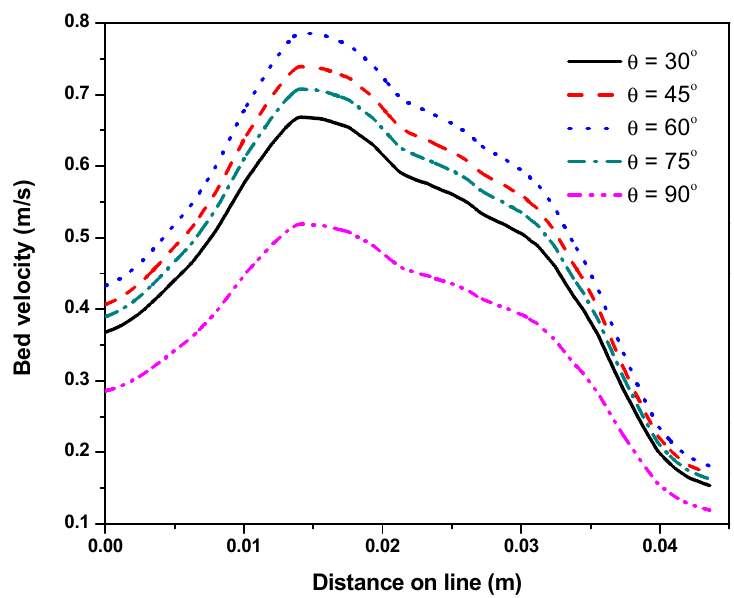
Figure 6. Bed velocity as a function of distance on line for a 500 g bed weight and different blade inclination angles.